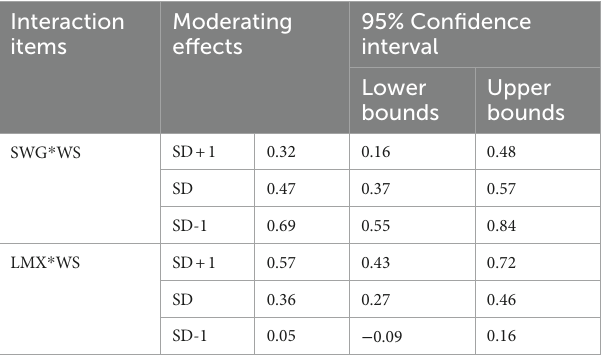
TABLE 5 Test for moderating